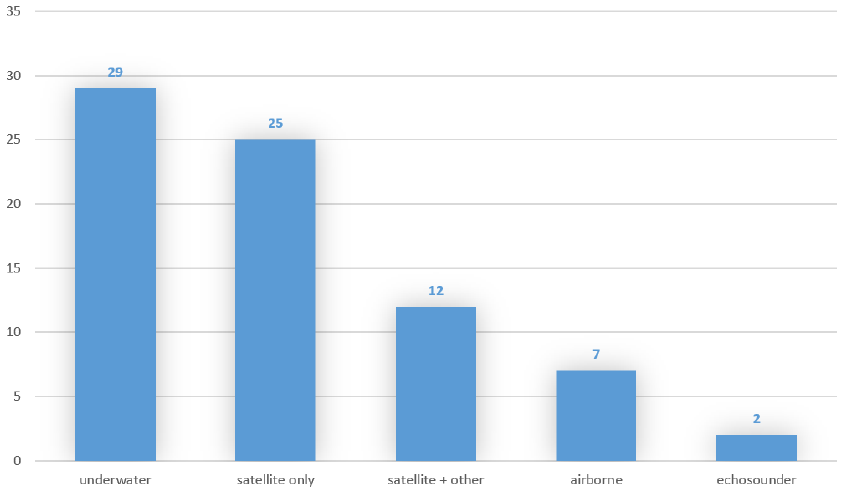
Figure 2. Bar plot presenting the data sources of 75 different papers from 2018 to 2020 studying corals classification or corals